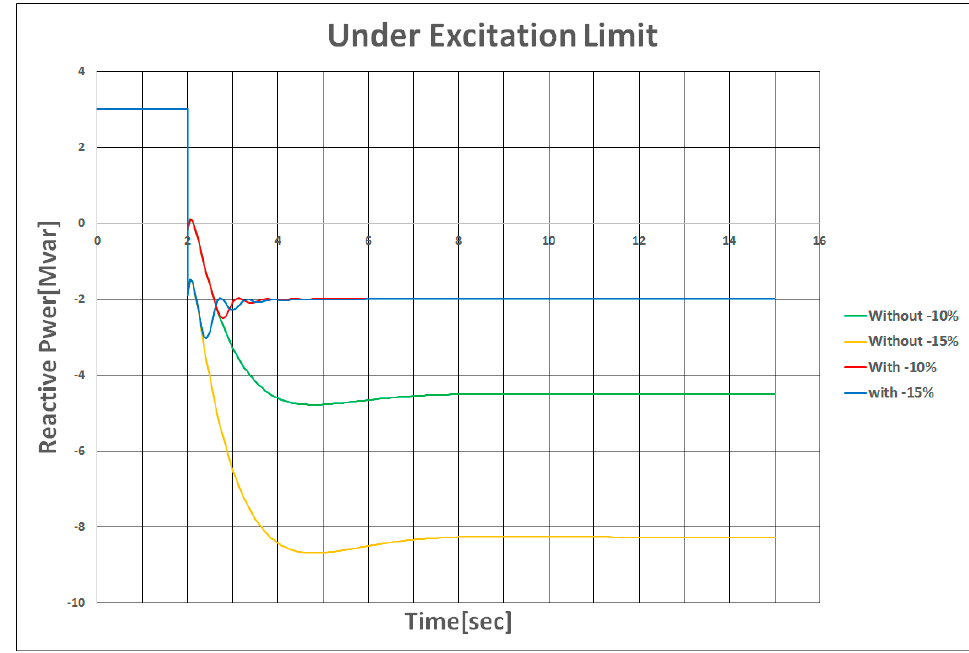
Figure 15. Comparison of results.